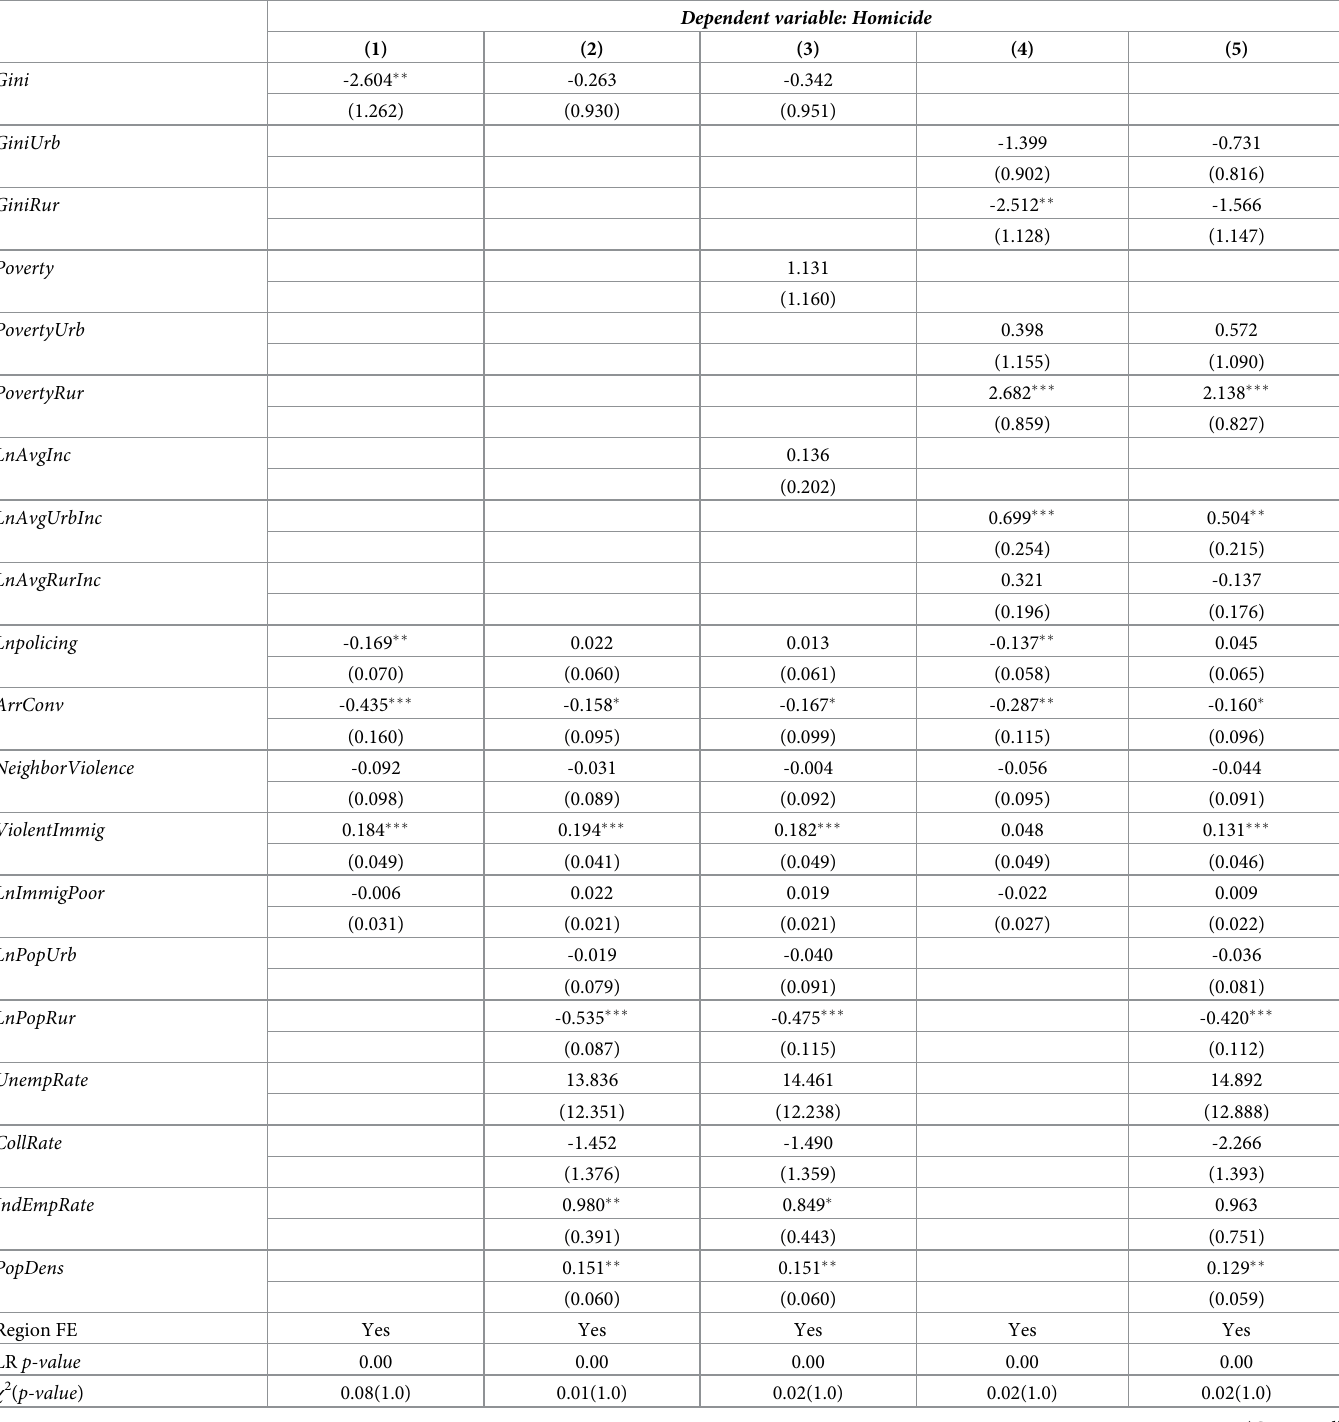
Table 5. Robustness check: The effect of GINI coefficient on